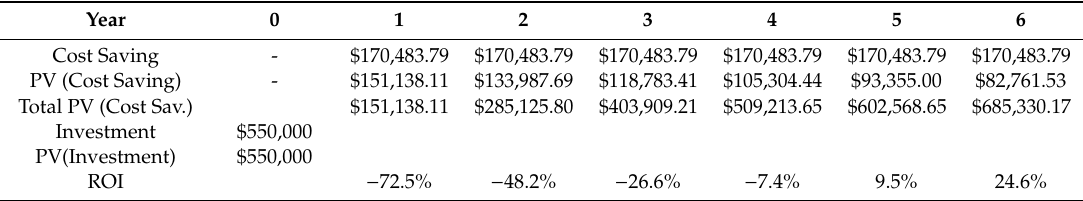
Table 6. Return of investment (ROI) calculation (95% failure reduction rate and 80% response